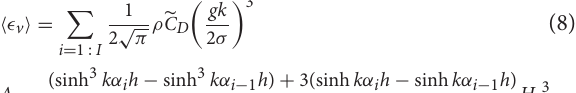
Figure 6 ) and leaves do not add significantly to the wave